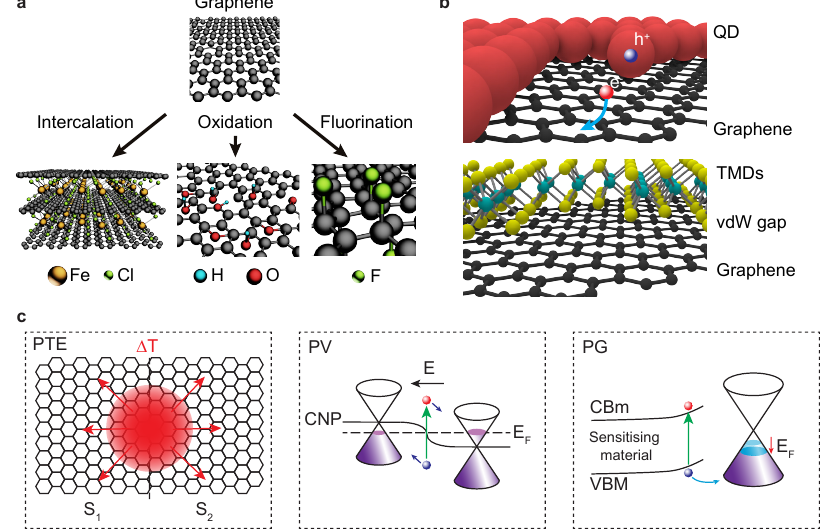
Figure 1. Materials and photodetection mechanisms in graphene-based devices. ( a ) Examples of functionalised graphene materials; ( b ) examples of hybrid/heterostructure graphene materials: quantum dots (QD) and van der Waals (vdW) heterostructures made with graphene and semiconducting TMDs; ( c ) three main mechanisms responsible for photo-activity in graphene-based